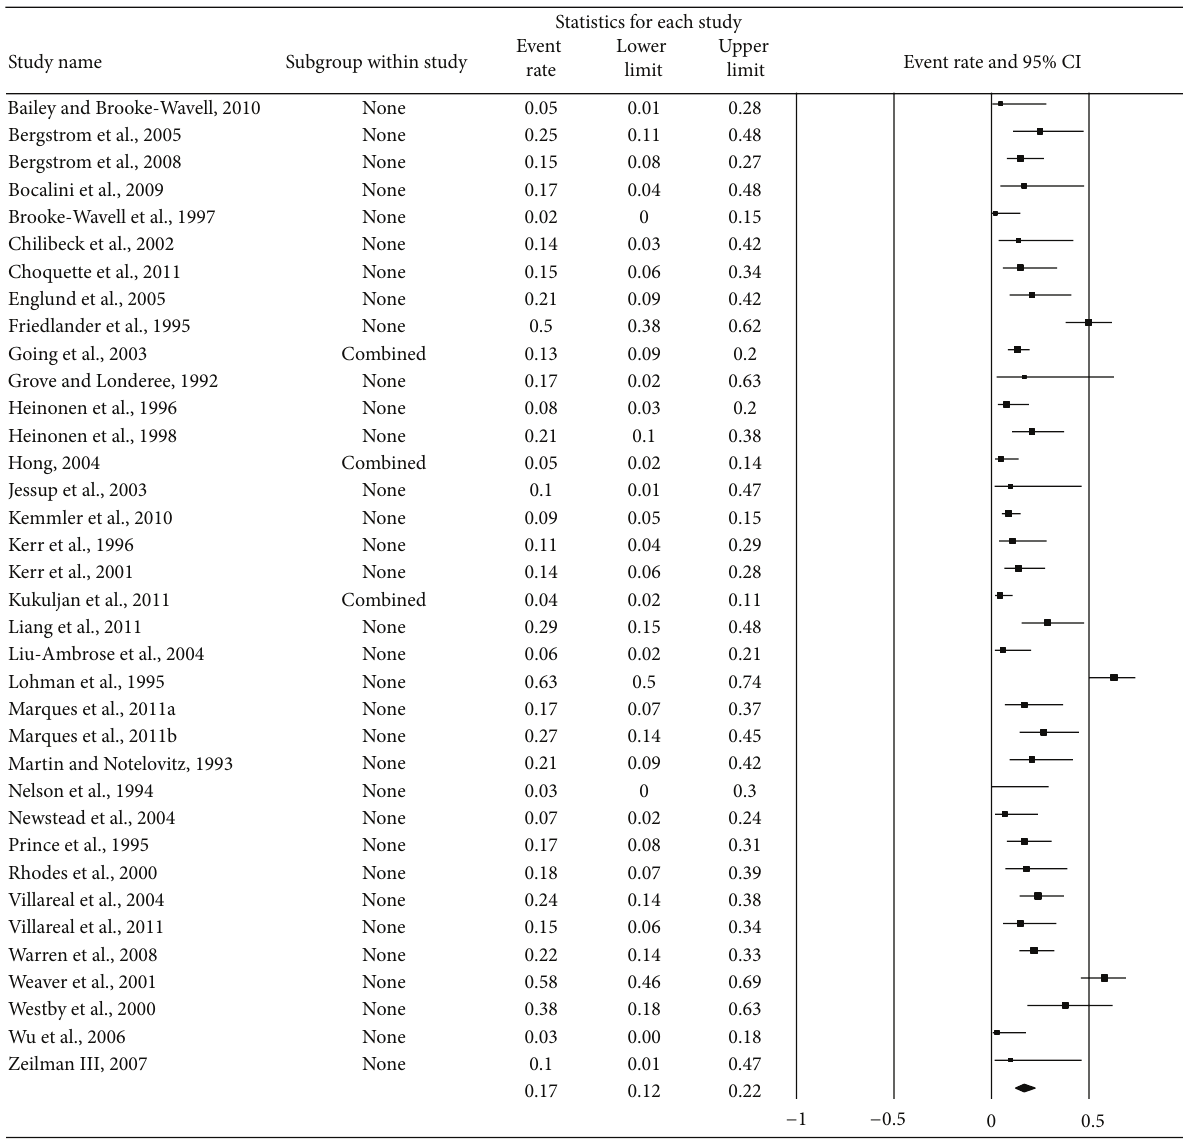
Figure 6: Forest plot for control dropouts (study level). Forest plot for control dropouts at the study level. The black squares represent the mean event rate while the left and right extremes of the squares represent the corresponding 95% confidence intervals. The middle of the black diamond represents the overall mean event rate while the left and right extremes of the diamond represent the corresponding